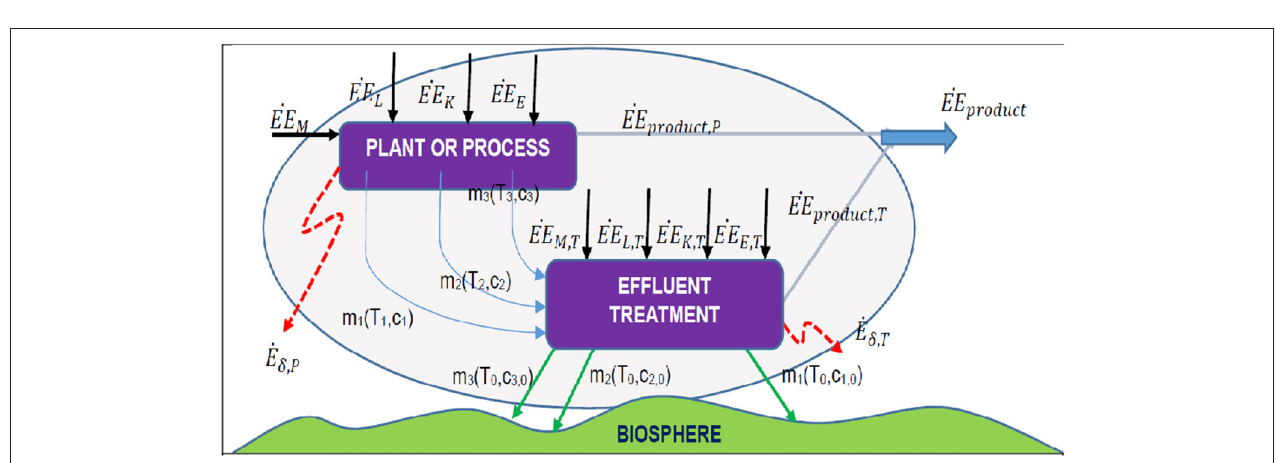
FIGURE 11 | Illustrative sketch of the procedure for the calculation of EE env in EEA. ˙ EE product = ˙ EE product , P ± ˙ EE product , T + ˙ EE M , T + ˙ EE E , T + ˙ EE L , T + ˙ EE K , T